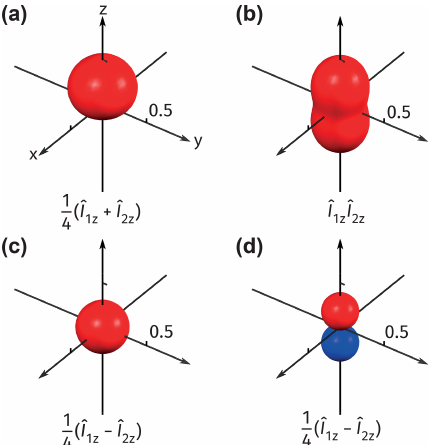
Figure 2. (a–c) Visualizations using the measurement observ- able ( | 1 , 1 (cid:105)(cid:104) 1 , 1 | ) ˆ n for the following density operators: (a) ˆ ρ = (1 / 4) 1 + (1 / 4)( ˆ I 1 z + ˆ I 2 z ), representing a state orientated along ˆ z ; (b) ˆ ρ = (1 / 4) 1 + ˆ I 1 z ˆ I 2 z , representing a state aligned along ˆ z ; (c) ˆ ρ = (1 / 4) 1 + (1 / 4)( ˆ I 1 z − ˆ I 2 z ), representing a state that appears